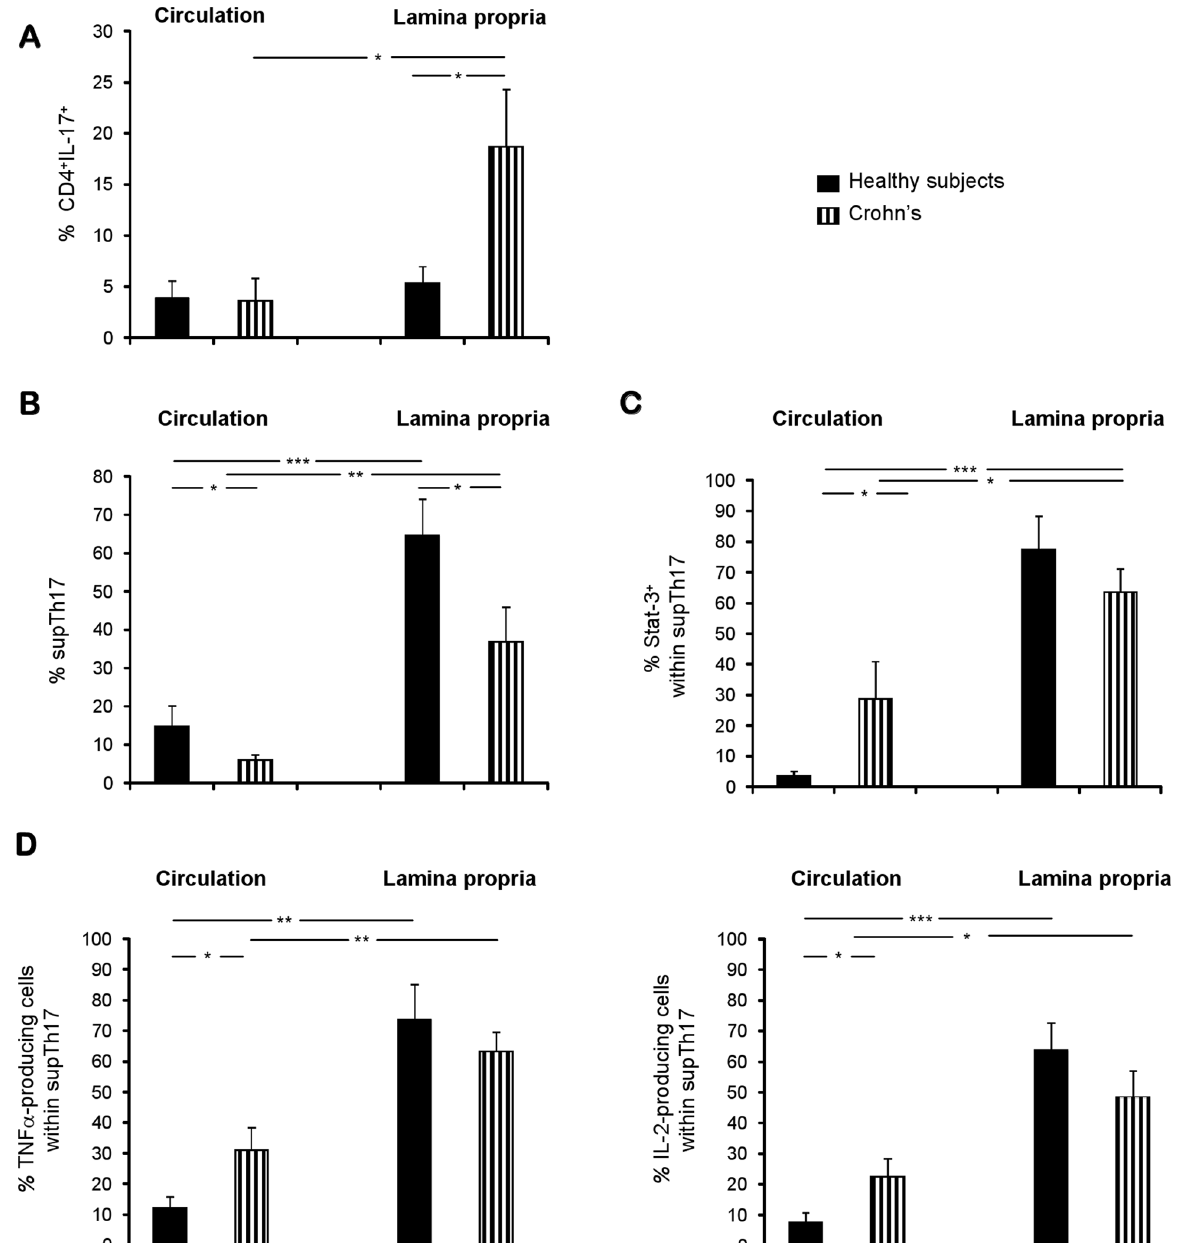
Figure 7. Demonstration of supTh17 cells in healthy subjects and associated decreases in Crohn’s disease. The frequency of CD4 + IL-17 + and of supTh17 was determined in PBMCs and LPMCs by flow cytometry. supTh17 were identified by initially gating CD4 + CD45RO + cells within PBMCs or LPMCs and then by determining the proportion of CD39 + IL-17 + and FOXP3 + within them. Mean ( + SEM) frequency of (A) CD4 + IL-17 + and of (B) supTh17 cells in the circulation and in the lamina propria. Mean ( + SEM) frequency of supTh17 positive for (C) Stat-3 and for (D) TNF- a and IL-2 in the circulation and in the lamina propria. Healthy subjects: n=17; Crohn’s: n=25; * P # 0.05; ** P # 0.01; *** P # 0.001.